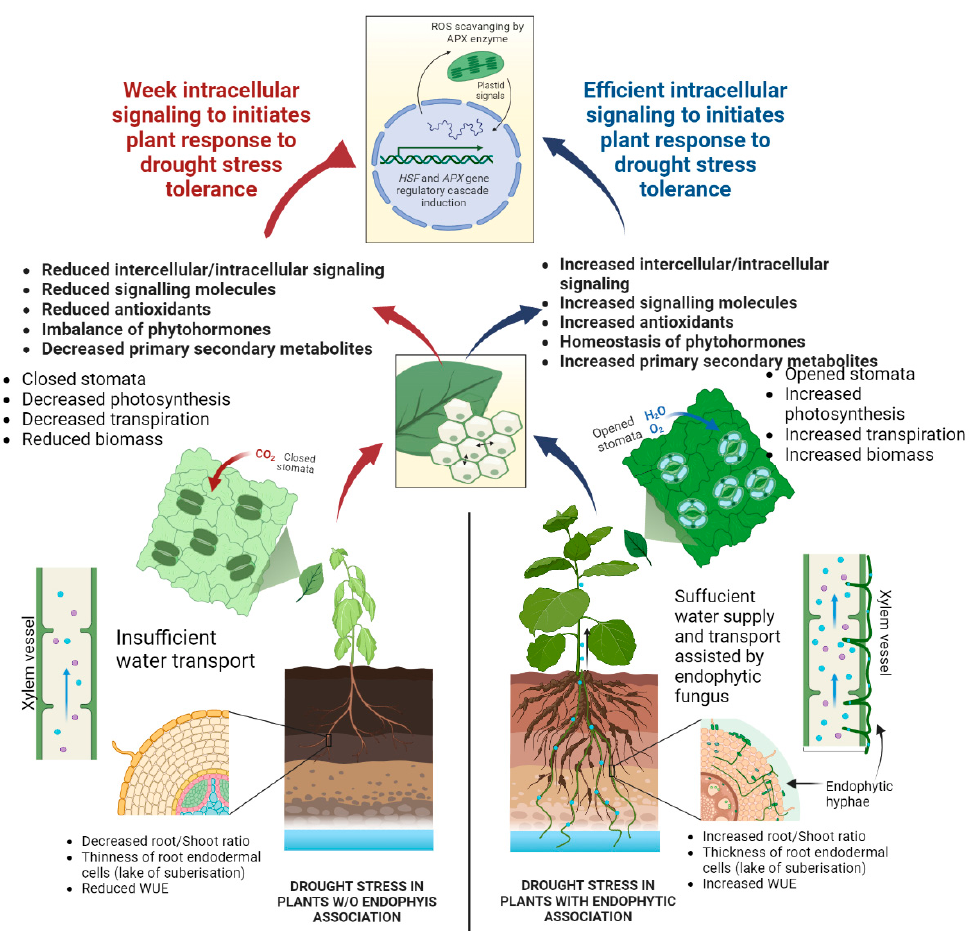
Figure 10. Working model showing a molecular mechanism regulating the drought stress toler- ance in M. oleifera driven by MolHSF3 and MolHSF19 transcription factors and APX genes induced by growth-promoting, antioxidant-rich, endophytic fungal consortium (WA, TG, and TL3).